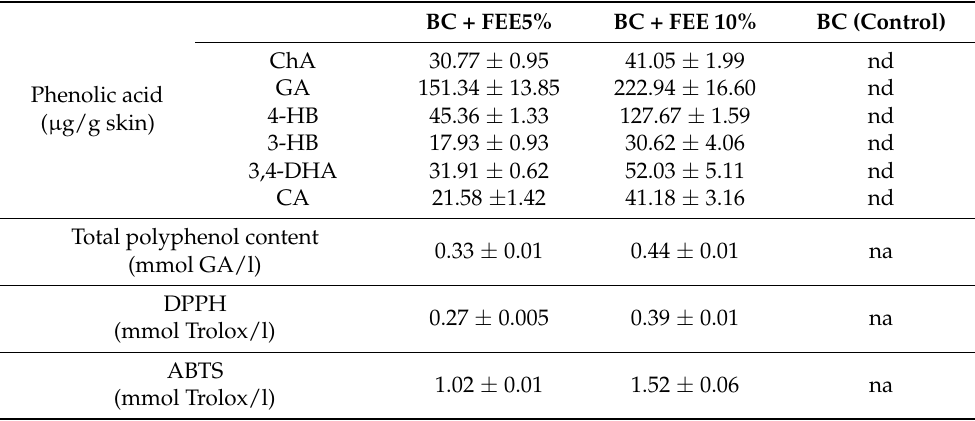
Table 7. Amount of the phenolic acids, the total polyphenol content, and antioxidant activity of fluid after skin extraction collected after 24 h penetration, n =